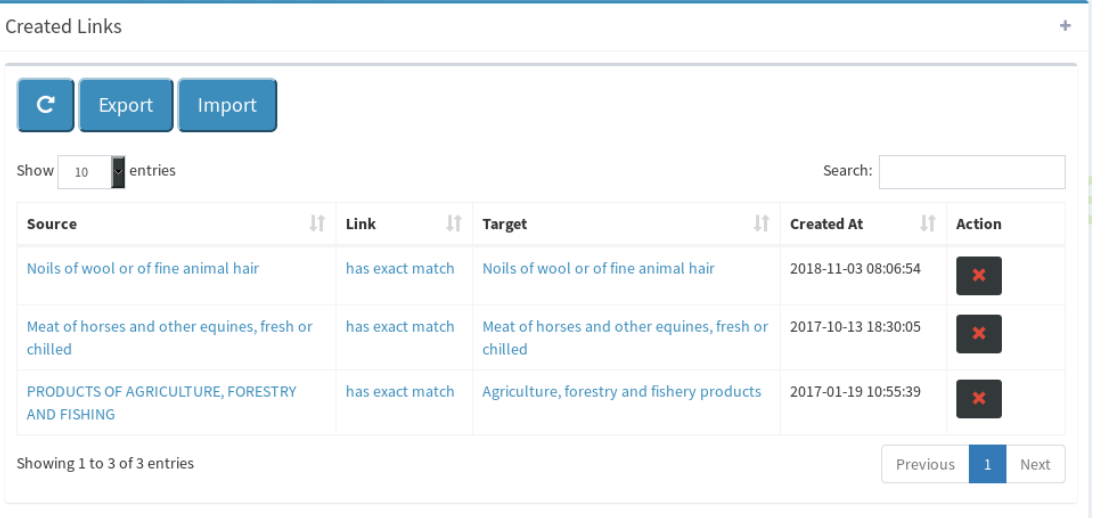
Figure 8. Created links